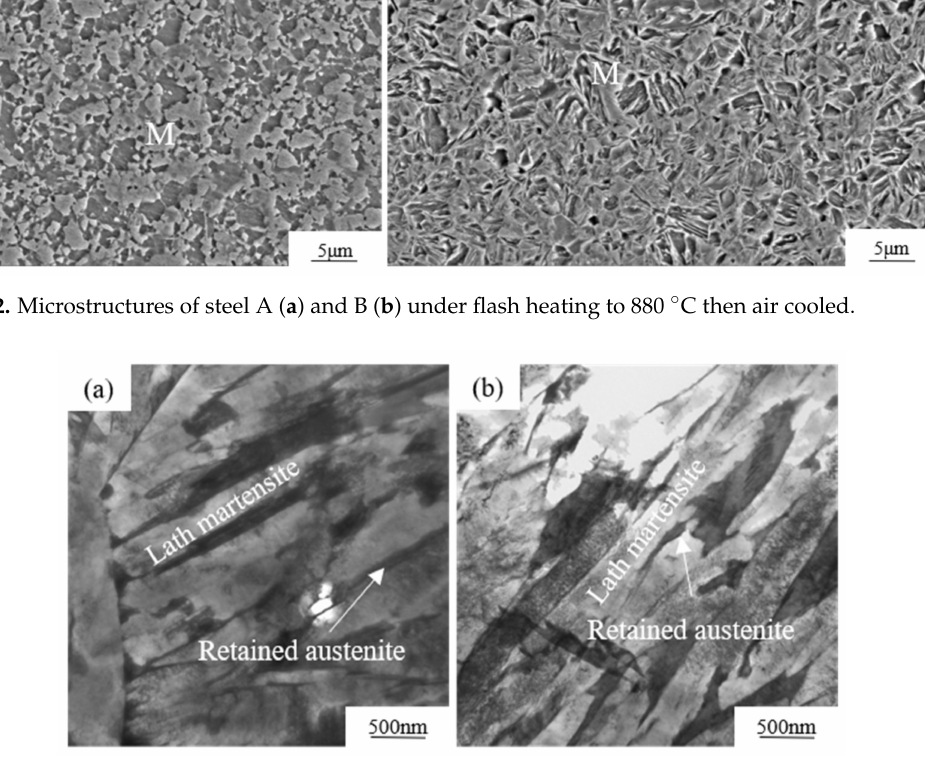
Figure 13. TEM analysis of lath martensite in steel A ( a ) and steel B ( b ) under flash heating to 880 ◦ C then air